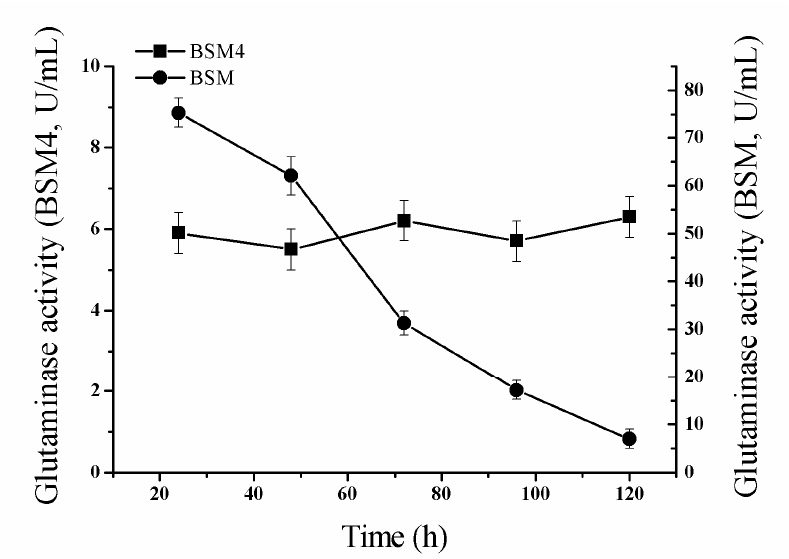
Figure 4. Analysis of the genetic stability of the recombinant strains BSM4 and BSM. The standard errors are calculated from three independent biological experiments.